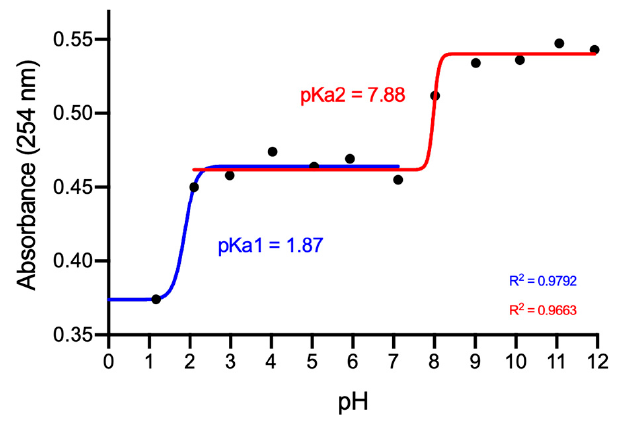
Figure 1. UV-pH titration of 8-TG.